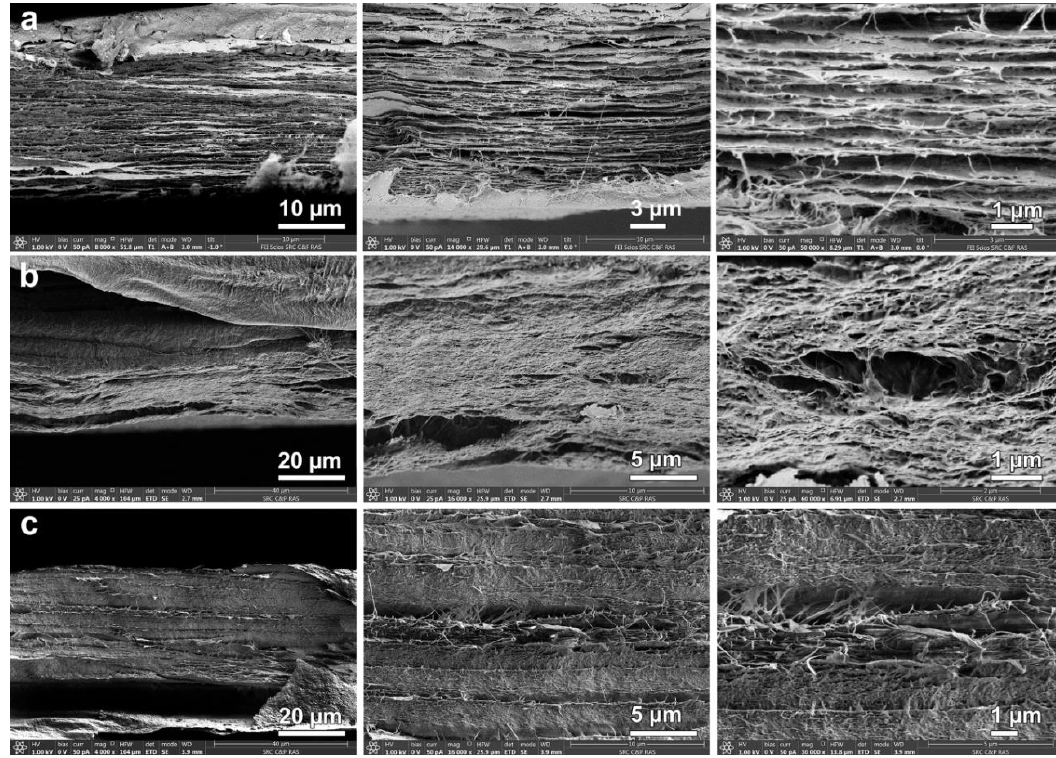
Figure 4. SEM images of cross-sections of: BC ( a ); BC–CAR–CS ( b ); and BC–HA–CS ( c ).